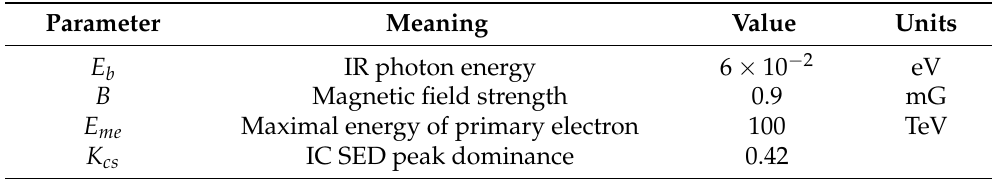
Table 1. Basic parameters of the proposed model.